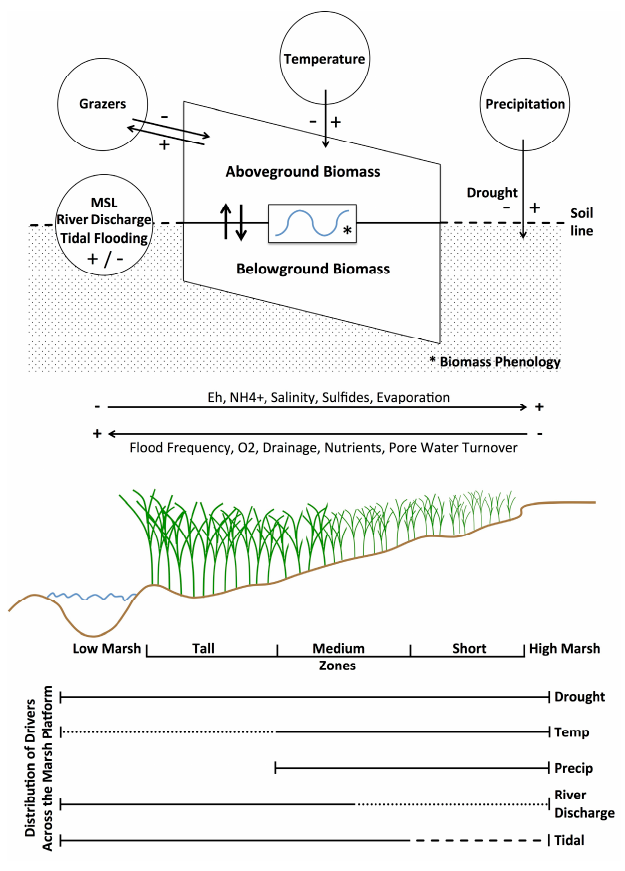
Figure 8. Conceptual model linking abiotic drivers to aboveground biomass via soil mediated interactions within the elevation gradient of the marsh platform. Gradient arrows (center) adapted from Mendelssohn and Morris [52].